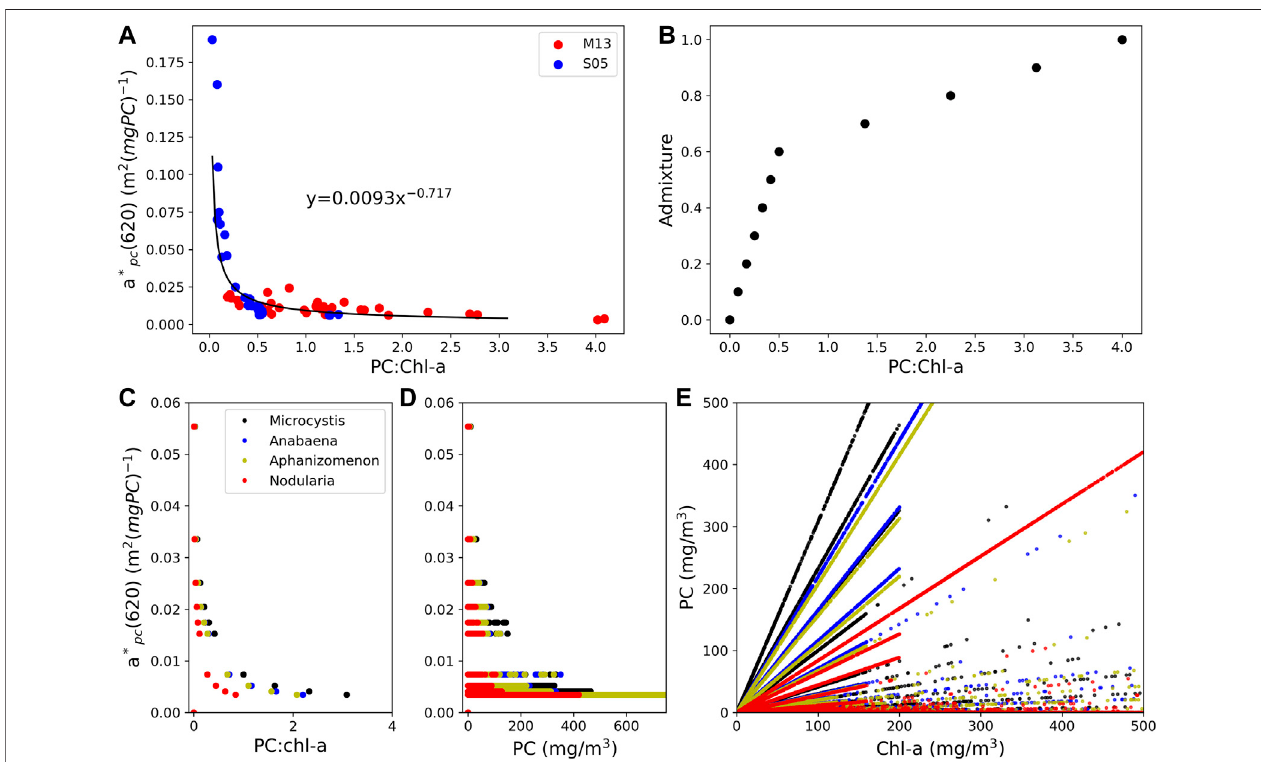
FIGURE 1 | (A) a p pc (620) plotted as a function of PC:chl-a from Matthews and Bernard (2013) and Simis et al. (2005), denoted as M13 and S05, with best fi t line in black, (B ) Visual of admixture scaling, where an admixture of 0.6 (60% dominance by cyanobacteria in population) is equal to a PC:chl-a of 0.5, (C) a p pc (620) for four cyanobacteria groups plotted as a function of PC:chl-a for modeled synthetic data, (D) a p pc (620) plotted as a function of PC concentration, (E) PC plotted as function of chl-a concentration.